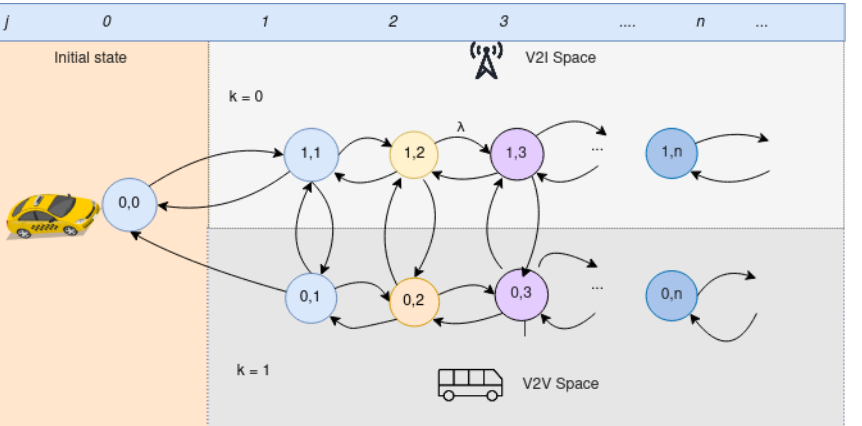
Figure 5. V2I and V2V 2D Markov